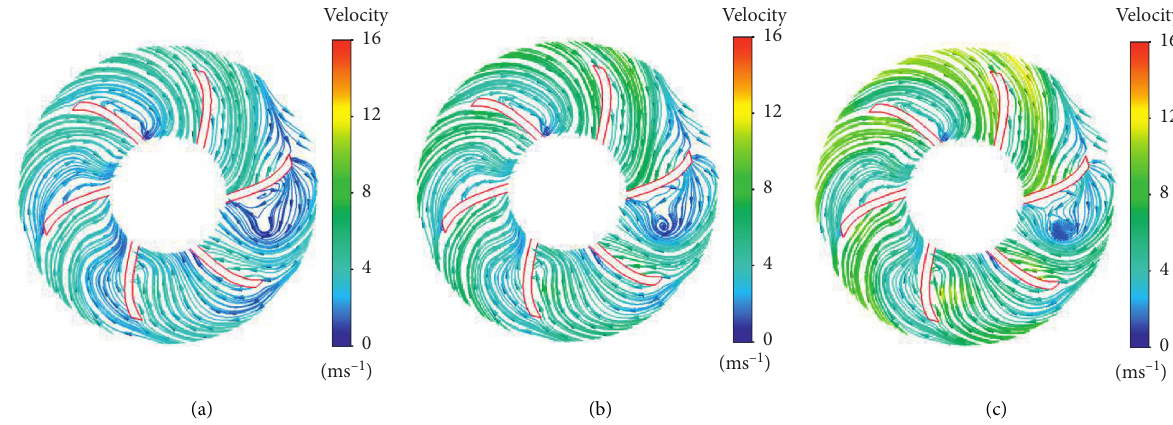
Figure 5: Velocity streamlines of runner at z � 0 plane: (a) 1000r/min (80m 3 /h); (b) 1500r/min (120m 3 /h); (c) 2000r/min (160m 3 /h).